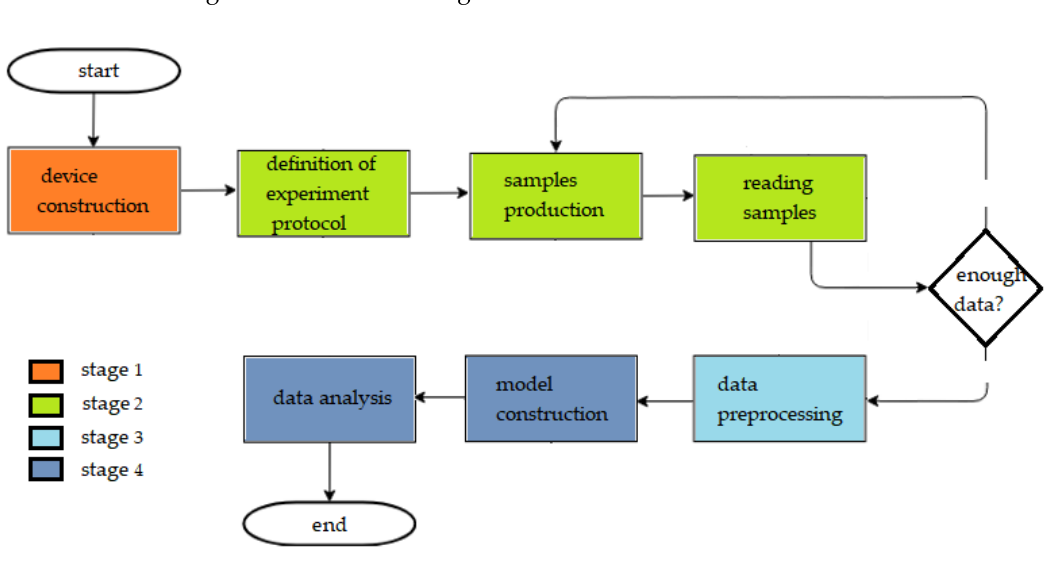
Figure 1. Flowchart of the adopted methodology.